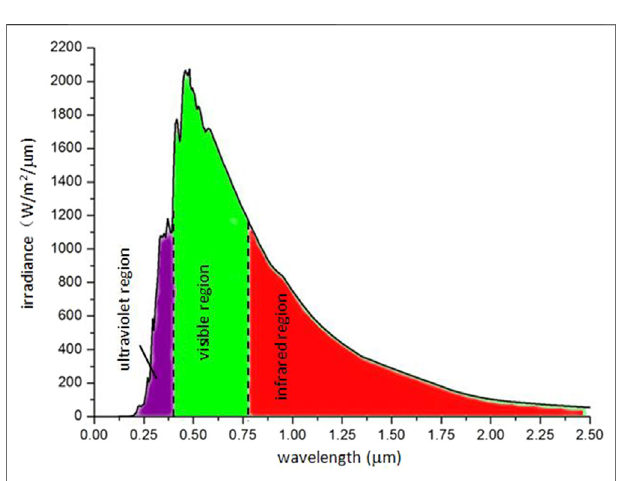
FIGURE 5 | Maximal solar spectral irradiance at 500 nm wavelength.